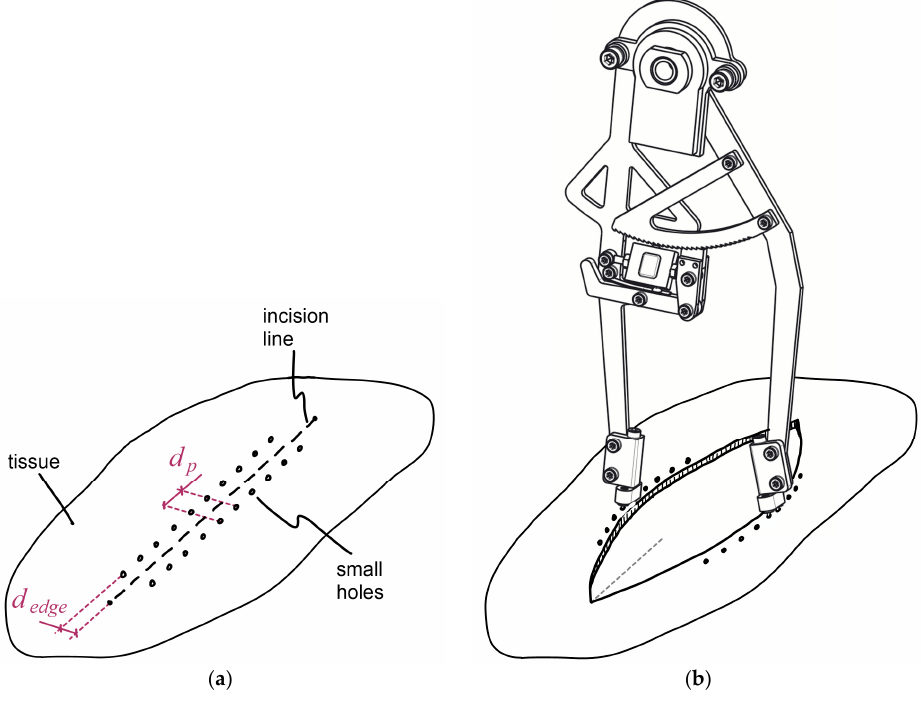
Figure 7. Measuring procedure: ( a ) Marks on the tissue that are required for the measuring process; ( b ) instrument linked to the tissue while measuring.